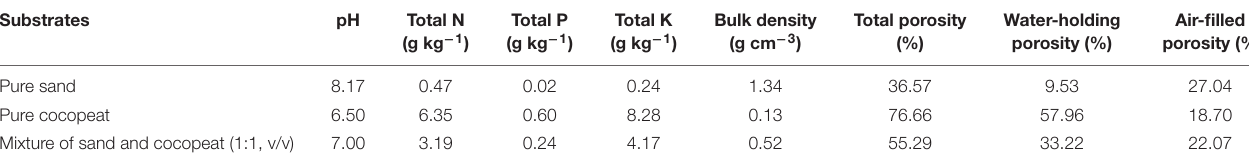
TABLE 1 | Basic physico-chemical properties of three different substrates. Substrates pH Total N Total P Total K Bulk density